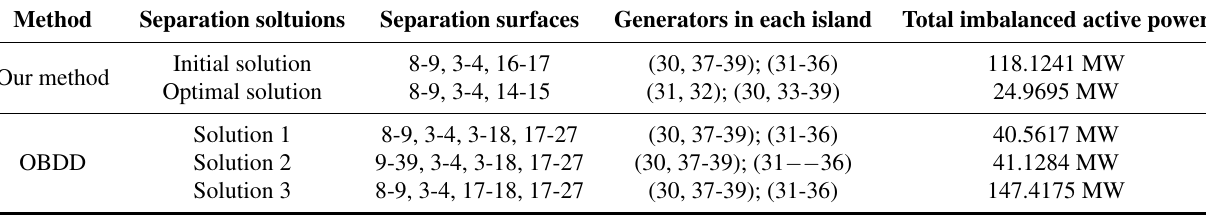
Table 4. Optimal separation surface searching with our method and the ordered binary decision diagram (OBDD)